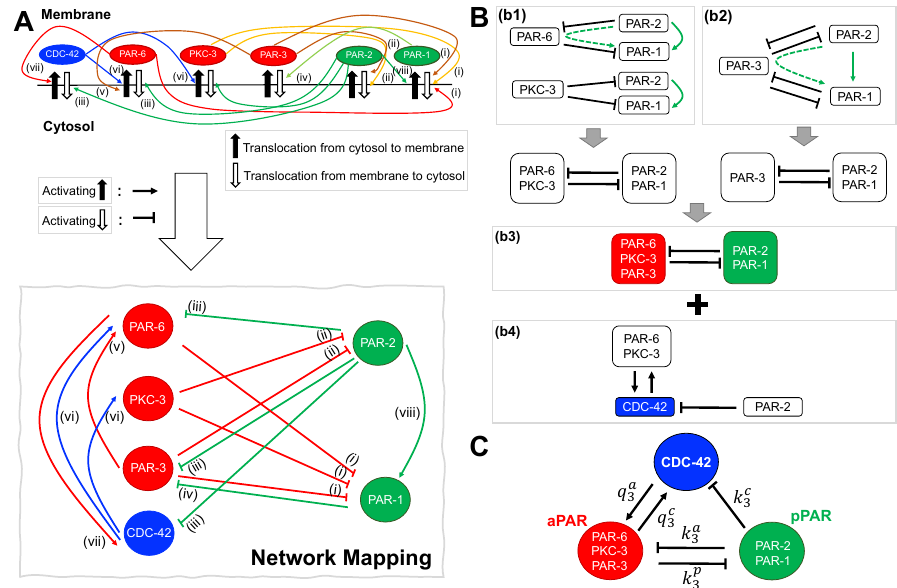
Figure 1. Interaction network of PAR proteins and the Rho GTPase CDC-42. ( A ) Top: Interaction network between PAR proteins and CDC-42 consistent with experimental results. References for interactions (i)–(viii) are given in Section 2.1 of the main text. Bottom: Interaction network used in this study, with cytosol to membrane translocation represented by activation, and membrane to cytosol translocation represented by inhibition. ( B ) Reduction of interaction network in ( A ) into subnetworks. The interaction network is separated into three modules: (b1) shows the interactions between the anterior Par proteins PAR-6 and PKC-3 and the posterior Par proteins PAR-1 and PAR-2, (b2) shows the interactions between the anterior Par protein PAR-3 and the posterior Par proteins PAR-1 and PAR-2, and (b4) shows the interactions between the anterior and posterior Par proteins and the Rho GTPase CDC-42. Note that the upregulation of PAR-6 by PAR-3 is implicitly captured by the inhibitory action of PAR-3 on PAR-2, since the latter in turn downregulates PAR-6. As described in the text, (b1) and (b2) can be reduced to (b3). The green dotted arrows indicates two sequential inhibition interactions ( (cid:62)⊥ ) that are equivalent to an activating interaction ( ↑ , solid green line). ( C ) Network (b3) merged with (b4) is the fundamental network investigated here. Rate constants q a the corresponding model Equations